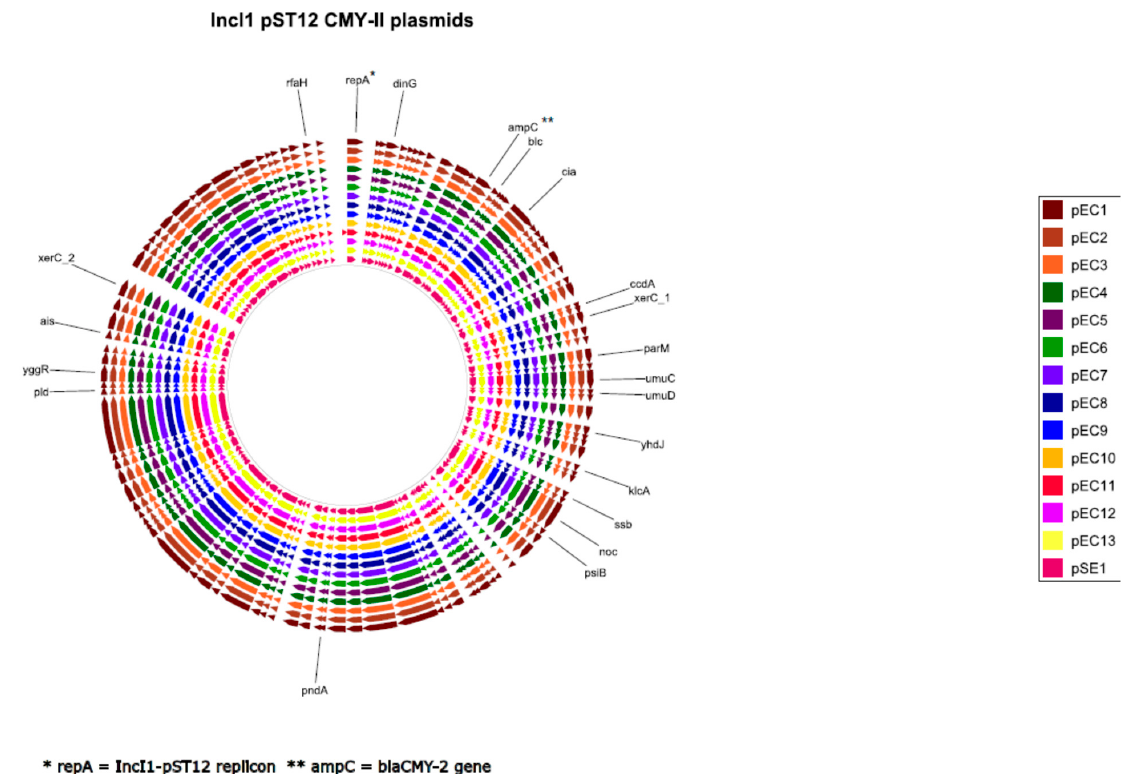
Figure 2. GView alignment of the various plasmid sequences. Each arrow represents a coding sequence and not necessarily transcriptional direction; gene names are depicted as generated by prokka. Table 4. Shufflon segments in variable regions of the different plasmids included (direction: ‘5–‘3). Plasmid Shufflon Segments